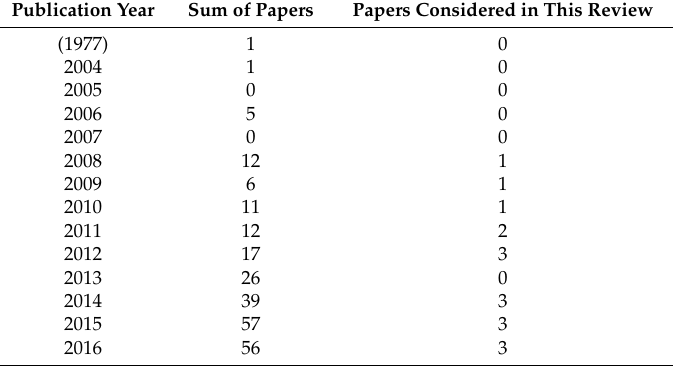
Table 2. Number of papers analyzed per publication year. The sum of all papers resulting from raw research within ISI Web of Knowledge, PubMed and Scopus (inclusion/exclusion criteria not considered) were reported in the second column. The number of papers selected and present in this work was reported in the third column. The only paper published before 2004 is reported in brackets. Publication Year Sum of Papers Papers Considered in This